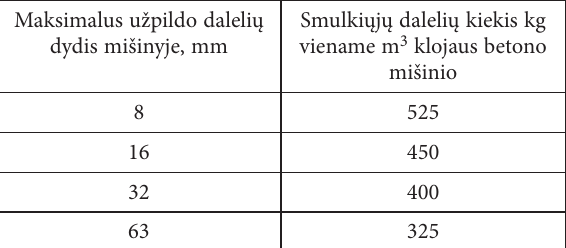
Table 1. Quantity of fine particles which is depended on the maximum size of